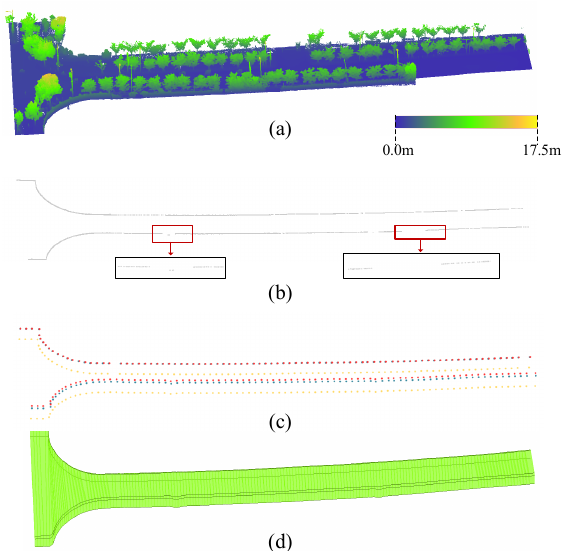
Figure 7 . Non-obstruction space construction example: (a) Raw MLS data, (b) Road boundary, (c) Key points, (d) Non- obstruction space.